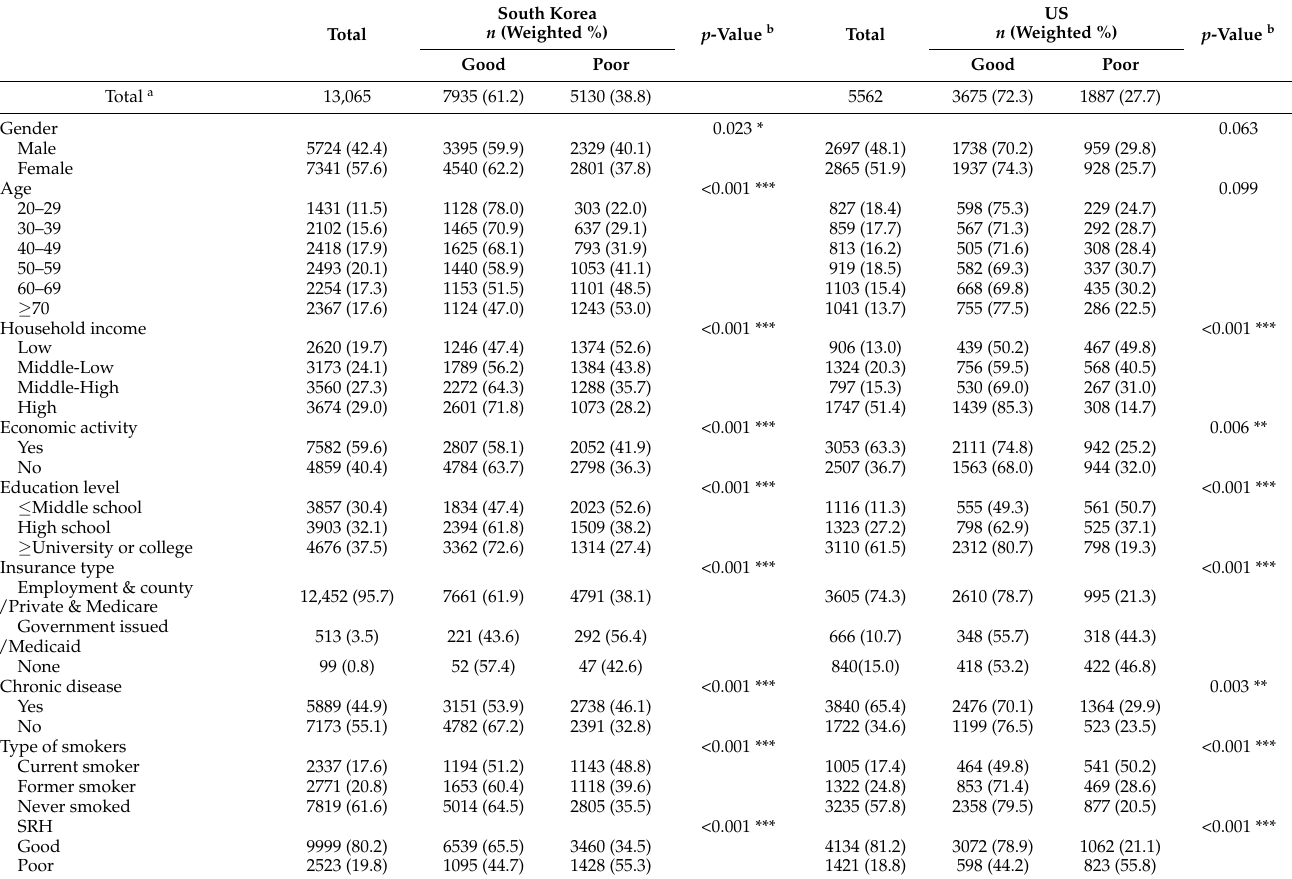
Table 1. General characteristics of the study populations.